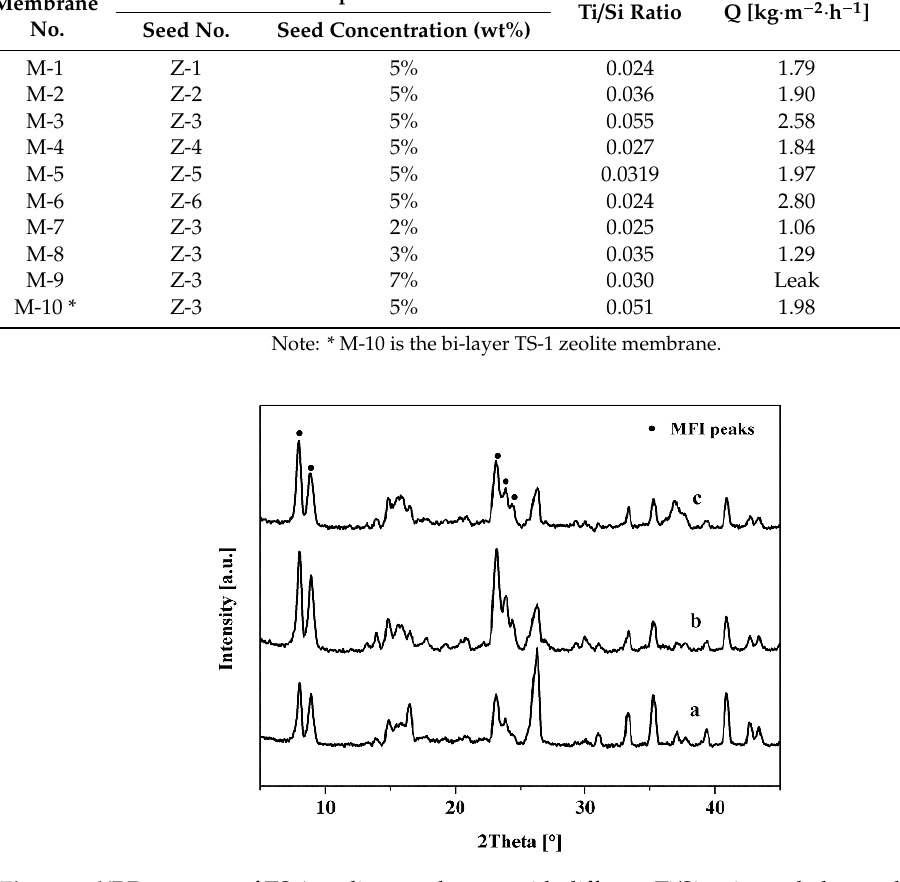
Figure 2. XRD patterns of TS-1 zeolite membranes with different Ti/Si ratio seeded crystals. ( a ) M-1; ( b ) M-2; ( c ) M-3.